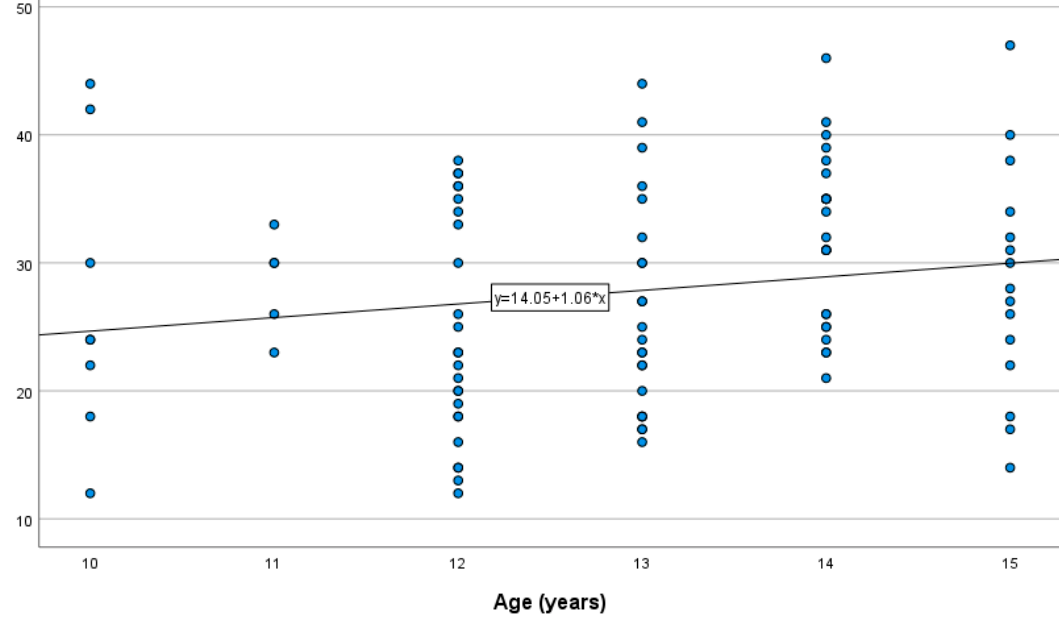
Figure 1. The distribution of the numbers of FP in categories of age (years). We also noticed differences in FP scores between tasters and nontasters ( p = 0.0211). The scores were higher in the group of tasters, for which the median score was 31 (23.0– 37.0), than in the group of nontasters, for which the median score was 25 (22.0–31.0) (Fig- ure 2).